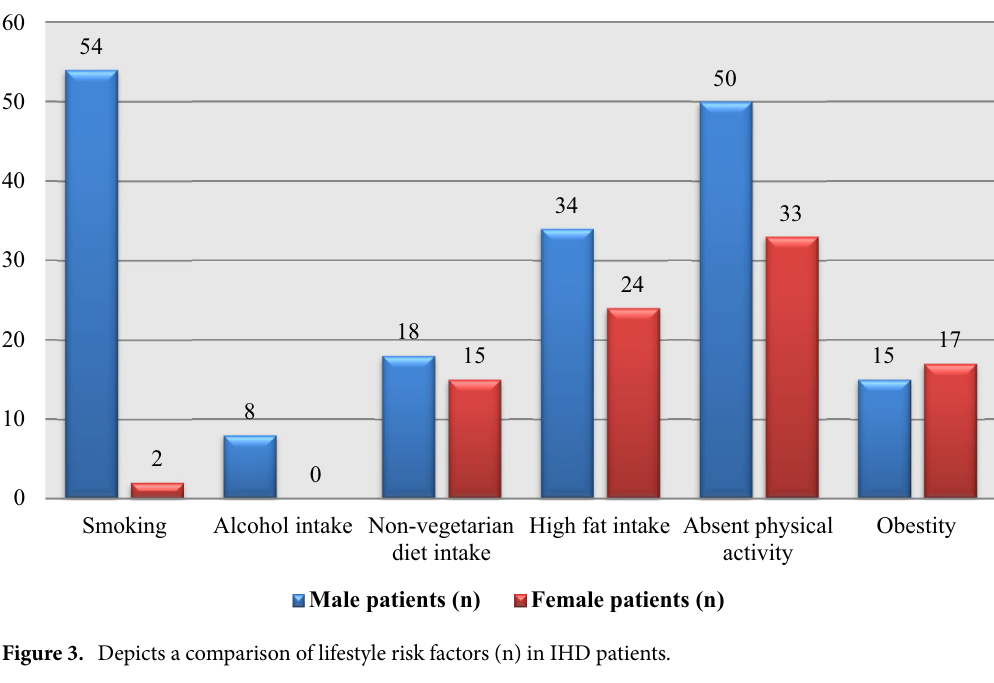
Males age ranges